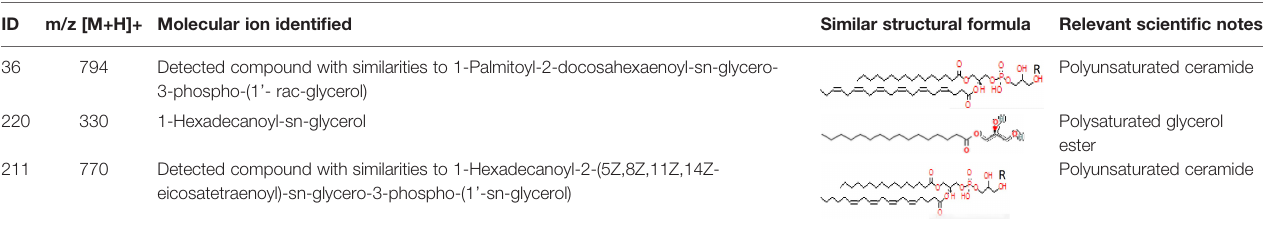
TABLE 3 | Identi fi cation of three similar structures within the